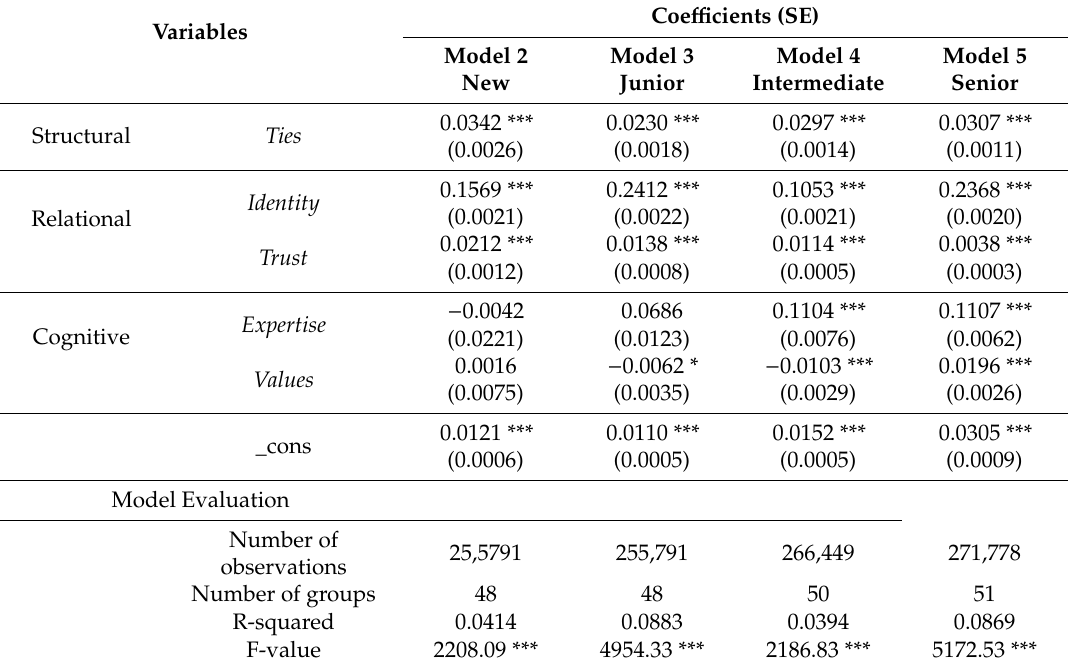
Table 5. Comparison of regressions on information sharing for di ff erent